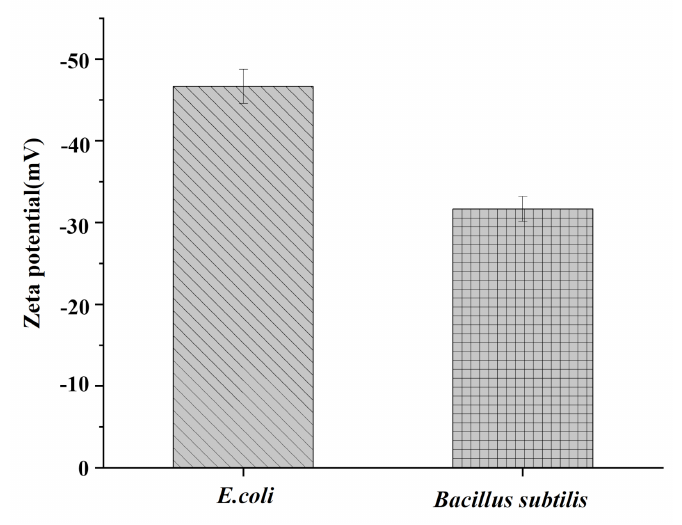
Figure 9. Zeta potential of E. coli and Bacillus subtilis . (pH = 7.4, 25 ◦ C, 3 × 10 3 CFU mL − 1